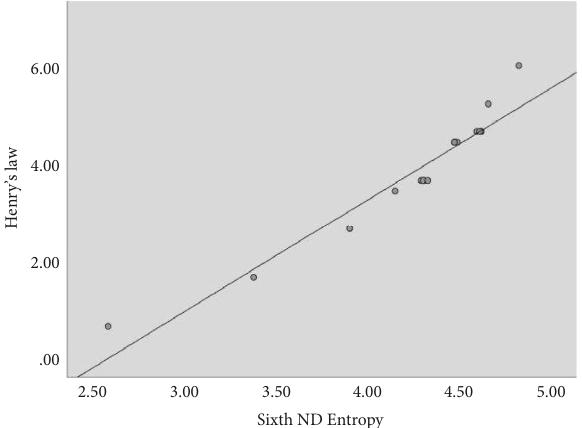
Figure 11: Graphical representation of LRM between Henry’s law and the sixth ND entropy.